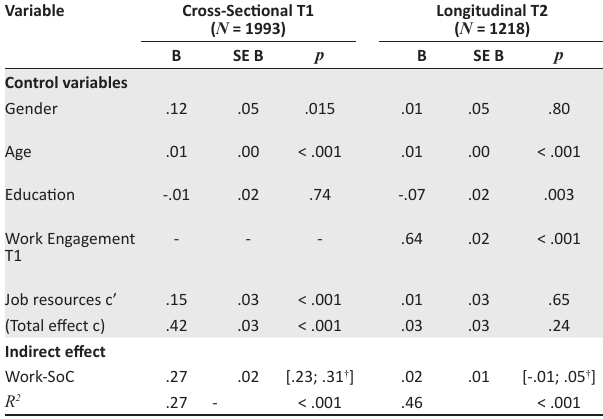
TABLE 3: Mediation analyses of job resources on work engagement via work- related sense of coherence. Variable